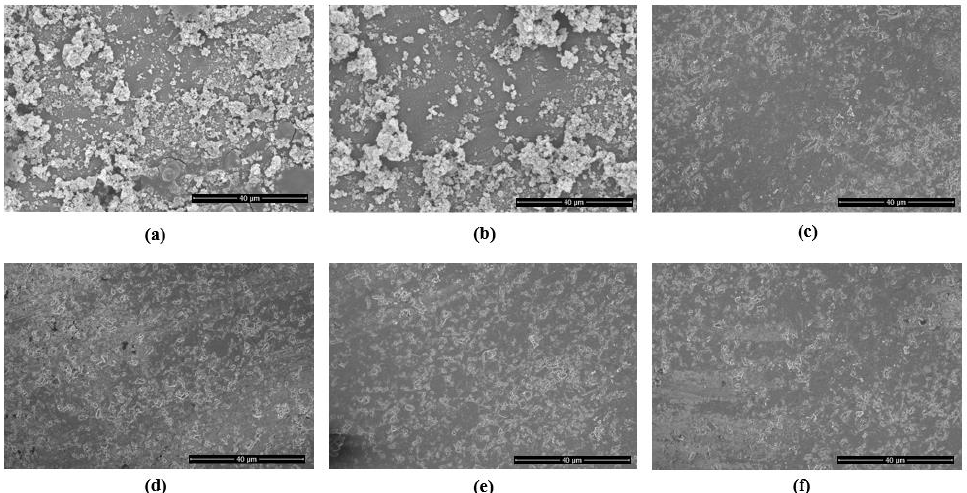
Figure 3. Representative SEM images of: ( a ) periodontal niche grown on PICN discs showing dense colonies (NT control specimen) ( b ) The specimen with MB shows no reduction in clustered colonies; ( c ) represents disc with CHX treatment; ( d ) DL therapy and; ( e ) PDT. The specimen ( f ) is shown to compare the sterile PICN disc (magnification 1500×).